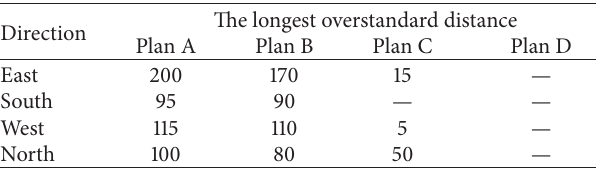
Table 3: The overstandard distances of industrial noise by Lanchow 330 kV substation